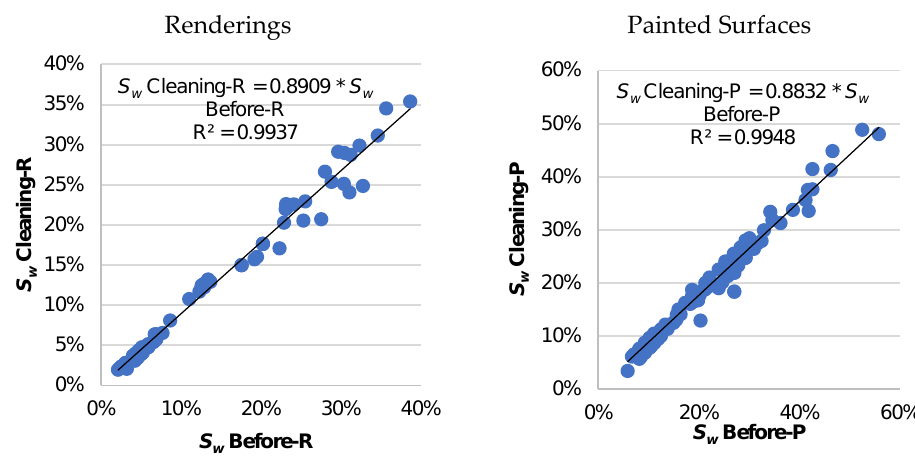
Figure 9. Dimension of the effect of S w -before on S w -cleaning.